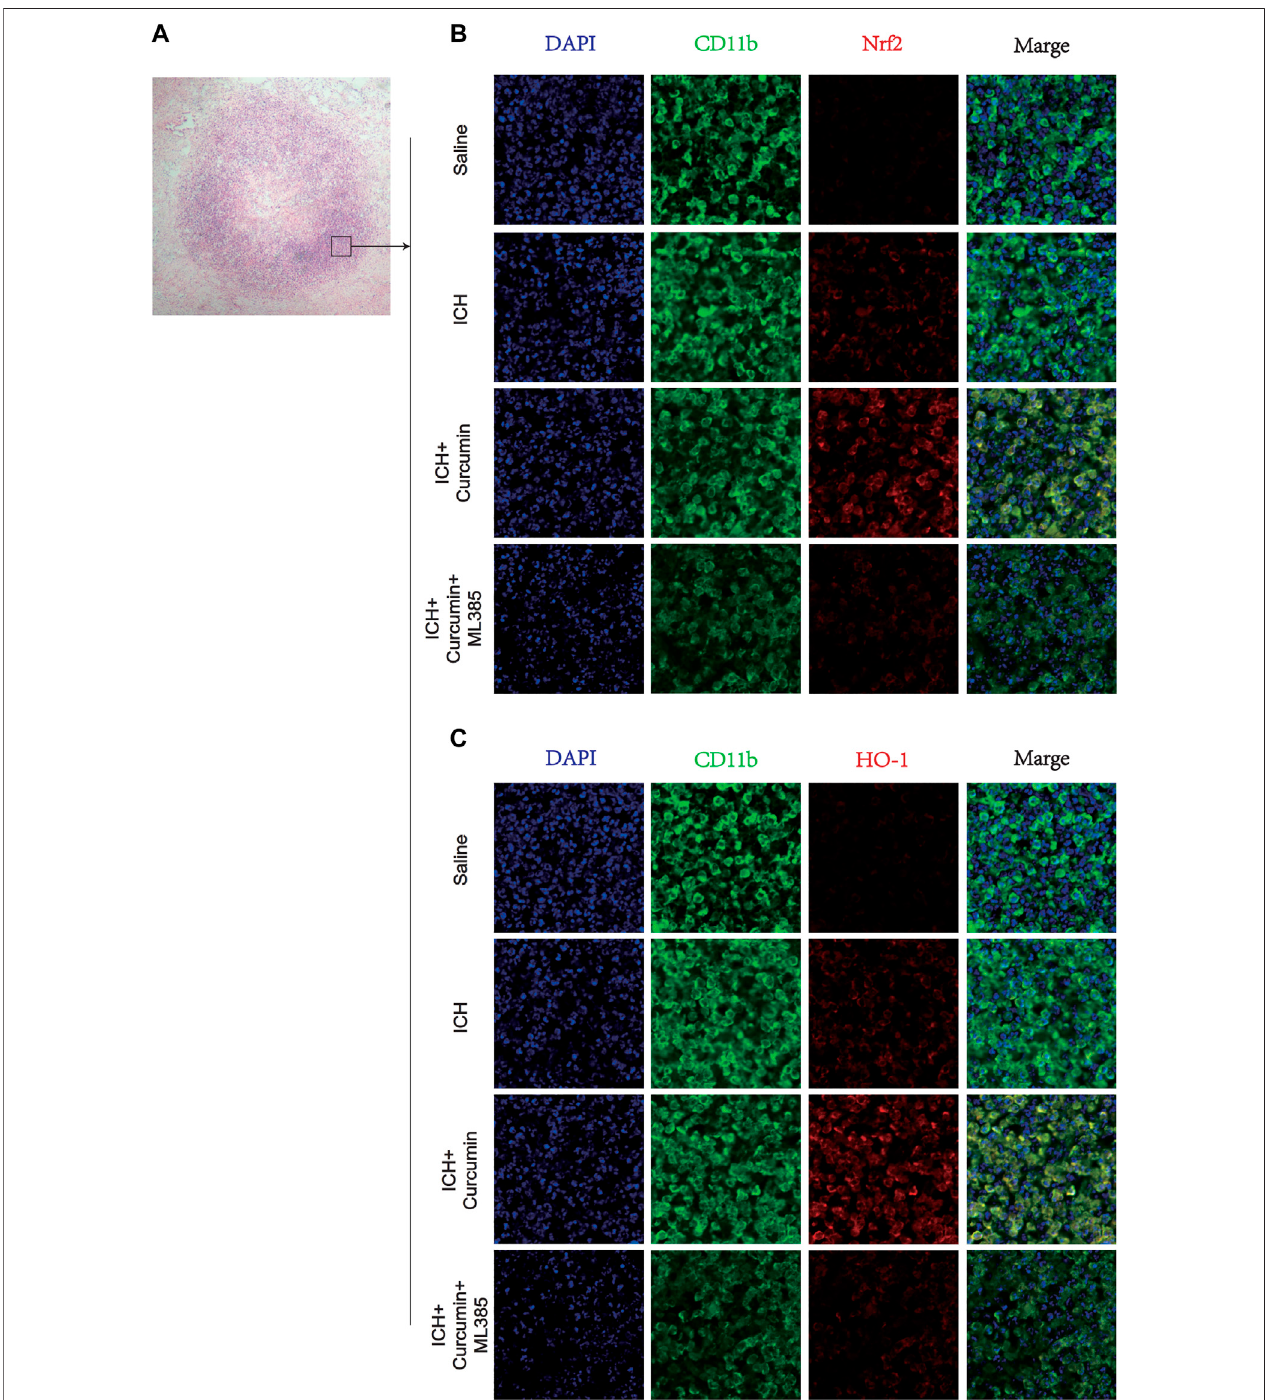
FIGURE8| Immuno fl uorescence stainingofmicroglia inthe surrounding hematomaat 7 days post ICH. (A) H&Estainingin thetissue surrounding the hematoma. (B) The microglial membrane protein CD11b was labeled with FITC, and the membrane protein Nrf2 was labeled with Texas Red. (C) The microglial membrane protein CD11b was labeled with FITC, and the membrane protein HO-1 was labeled with Texas Red. n = 3/group. The data are from at least three such independent experiments.